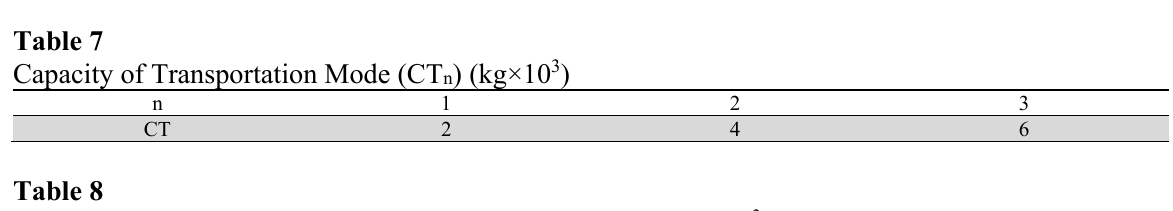
Purchasing cost of the row material from suppliers (C a i )( Rial×10 3 )